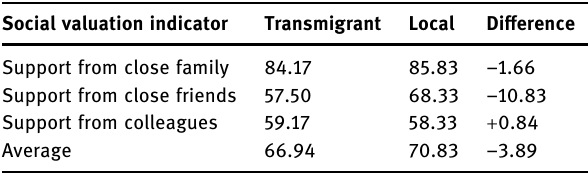
Social valuation indicator